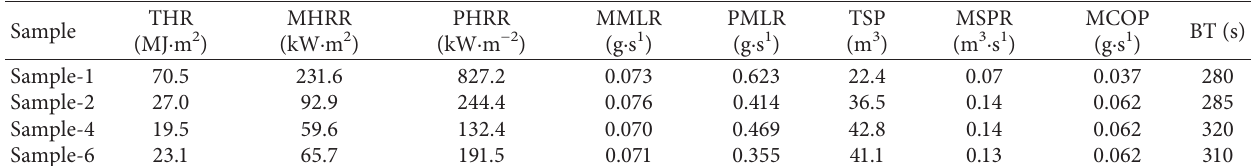
Table 2: Cone calorimeter test data of HIPS and